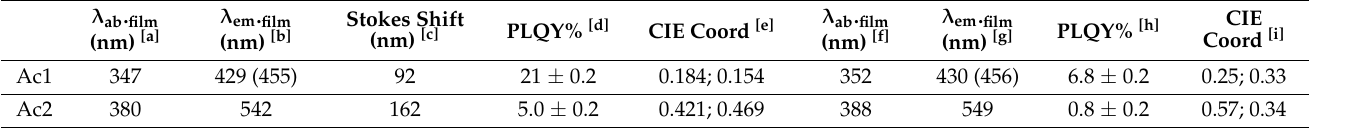
Table 1. Optical data recorded by UV-vis and fluorescence